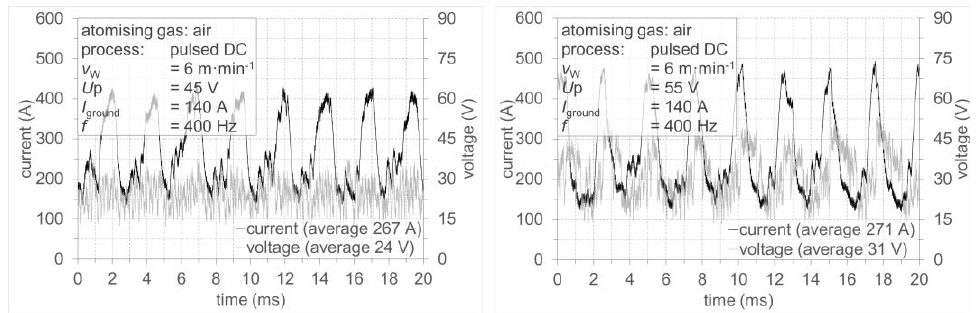
Figure 13. Current/voltage curve, pulsed direct current, ( left ): U p = 45 V, ( right ): U P = 55 V.